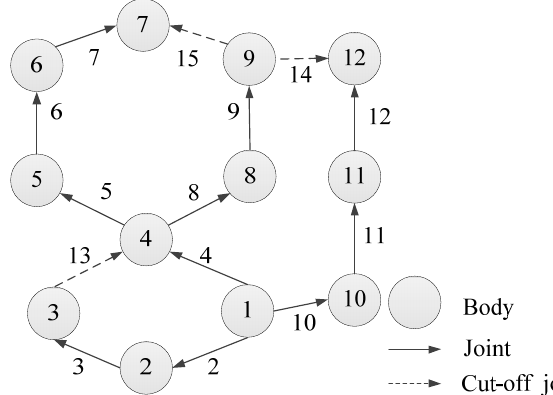
Figure 9. A multibody system with closed loops.